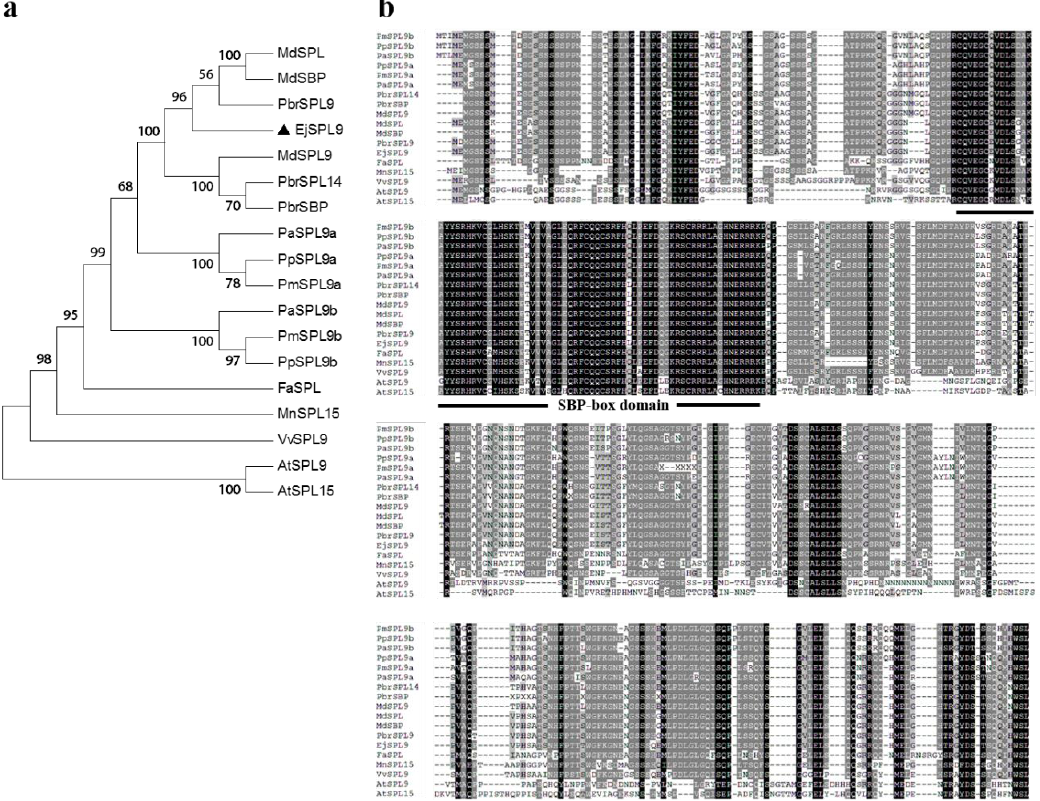
Figure 2. Sequence analysis of SPL9 from various species. ( a ) Phylogenetic tree of SPL9s in different species. Black triangle indicated EjSPL9. ( b ) Amino acid sequence alignment of SPL9s. Amino acids with black and gray represent 100% and 50% similarity, respectively; the underline indicated the SBP-box domain. Identical and similar amino acid residues are represented by black and grey shadows, respectively. The accession number of each gene is as follows: PbrSPL9 ( Pyrus × bretschneideri , XP_009369782.1), MdSPL ( Malus domestica , ADL36823.1), MdSBP ( Malus domestica , AHC08503.1),